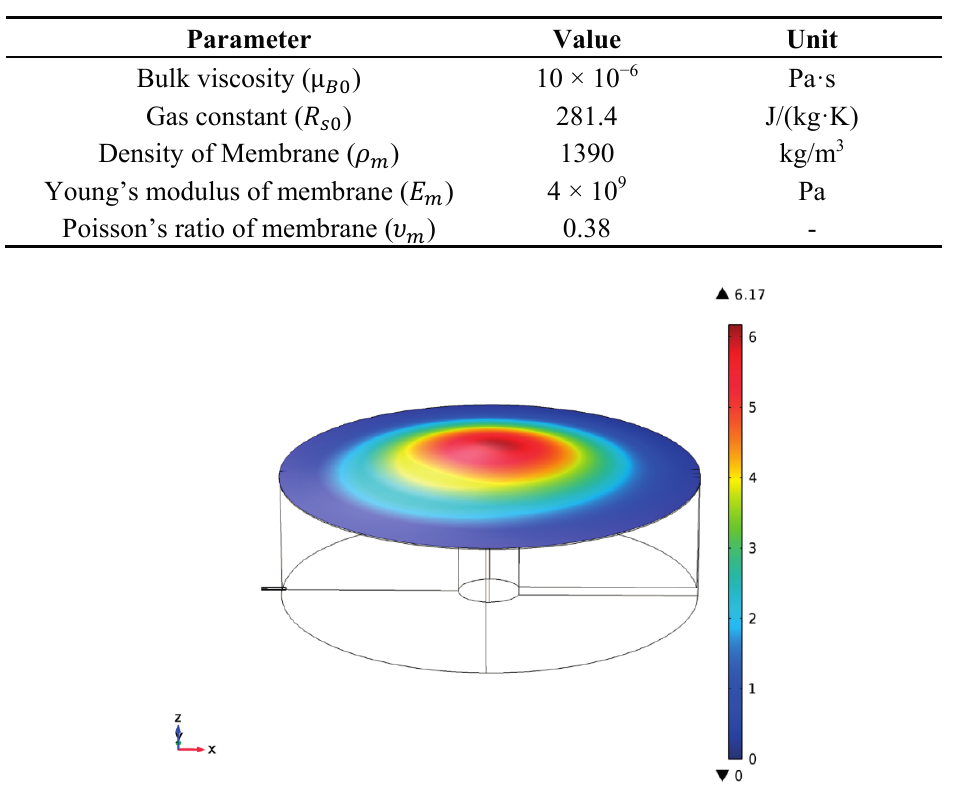
Figure 4. Measured displacement field of the membrane of the acoustic sensor at first resonance frequency ( (cid:1858) = 16,737 Hz) for (cid:1844) = 5 mm, (cid:1844) = 0.75 mm, ℎ = 3000 µm, (cid:3045) (cid:3040) (cid:3029) (cid:3030) = 500 N/m and (cid:1872) = 8 ℎ g = 30 µm, (cid:1846) (cid:3040) (cid:3040)